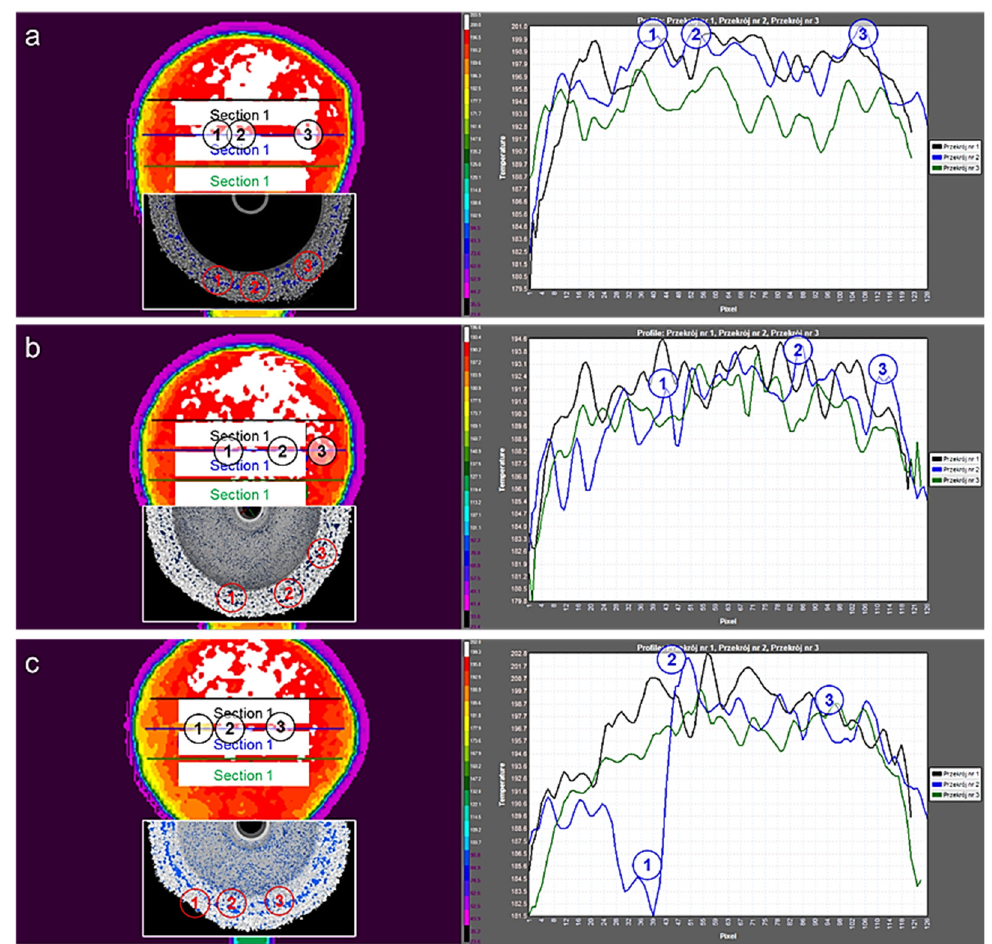
Figure 16. Thermograms and tomograms of spherical samples: M1 ( a ), M2 ( b ) and M3 ( c ).